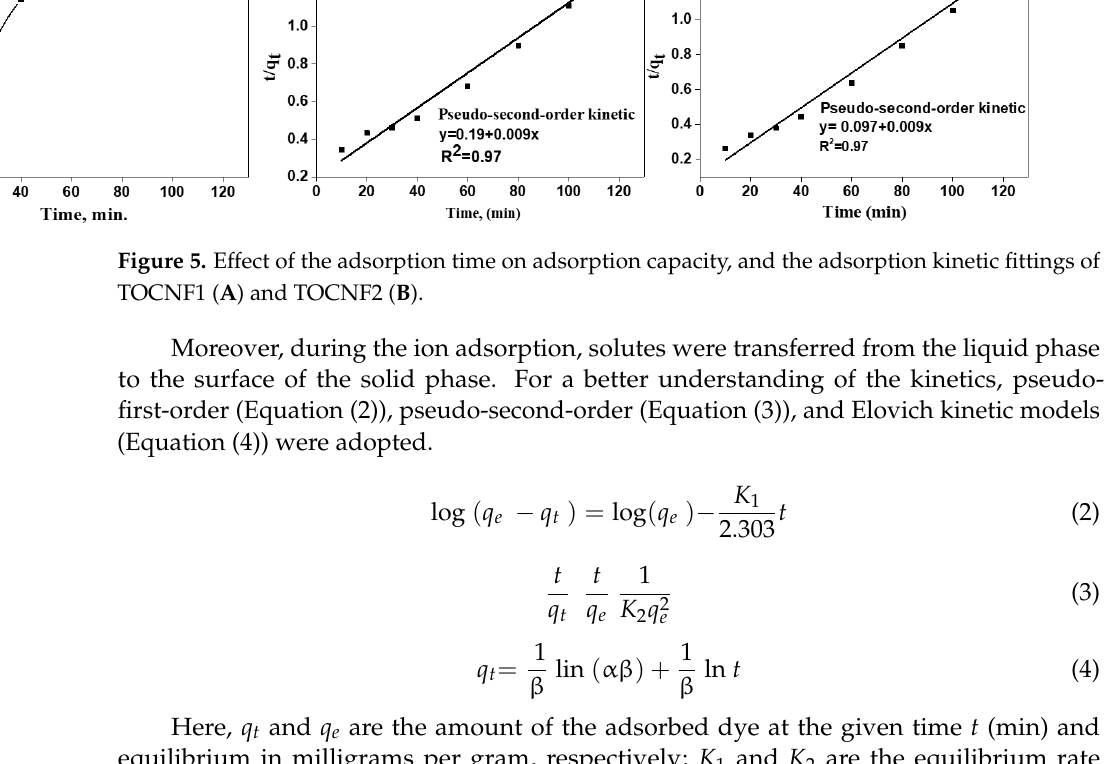
Figure 4. Effect of pH on the adsorption capacities of TOCNF1 (A) and TOCNF2 (B) towards MB (MB concentration: 100 mg/L; functionalized cellulose: 0.05 g/50 mL and contact time: 40 min).